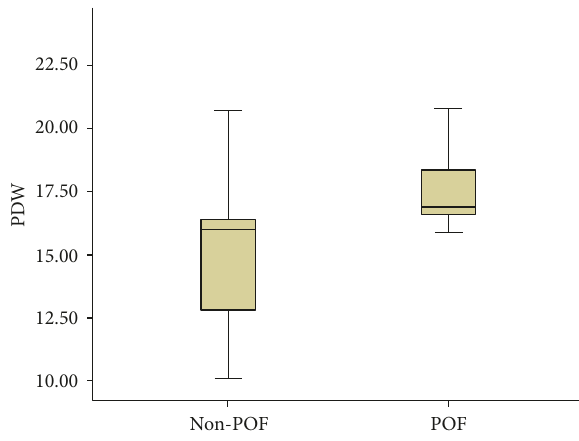
Figure 1: Box diagram of average serum PDW of POF and non-POF patients in